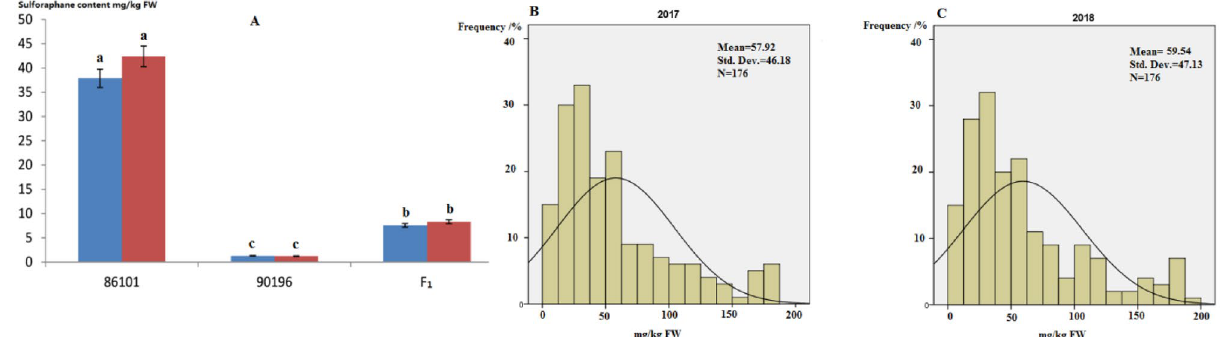
Figure 1. Biochemical variationof SF contents in the 86,101 and 90,196 lines and their hybrid (F 1 ) ( A ). The lowercase letters indicate the significant differences in SF contents between the two parents and their hybrid F 1 at p < 0.05. Frequency histogram of SF contents distributed in the DH population between 2017 ( B ) and 2018 ( C ).